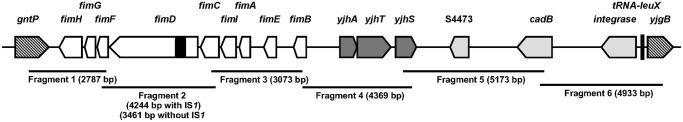
Characterization of the GI leuX in S. flexneri.The genetic organization of the ~23-kb GI inserted at the leuX locus in the S. flexneri reference strain 2457T is shown (drawn to scale). The gntP and leuX-yjgB genes flanking the GI are indicated by hatched arrows, fim genes by white arrows, yjhATS genes by dark-gray arrows and other genes present in the GI by pale-gray arrows. The position of IS1 in fimD is indicated by a black box. The position and sizes of the six PCR fragments generated for the tiling PCR are indicated below the genetic map; the expected sizes of PCR fragment 2 corresponding to fimD with and without IS1 are indicated. For the sake of clarity, other IS elements and phage remnants are not indicated.